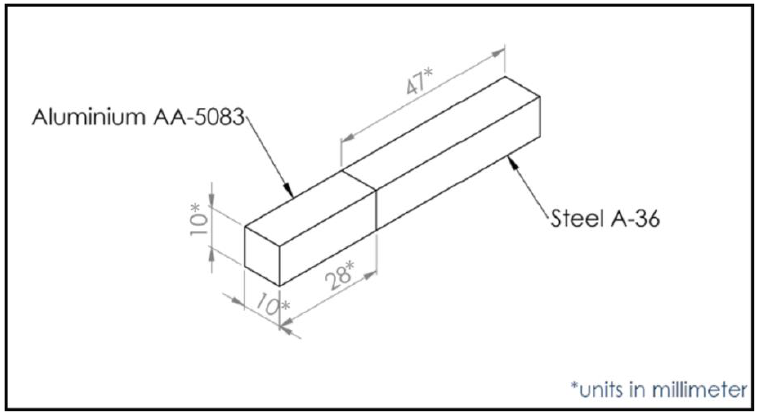
Figure 1. Dimension and joint configuration of the diffusion-bonded mild steel and aluminium.